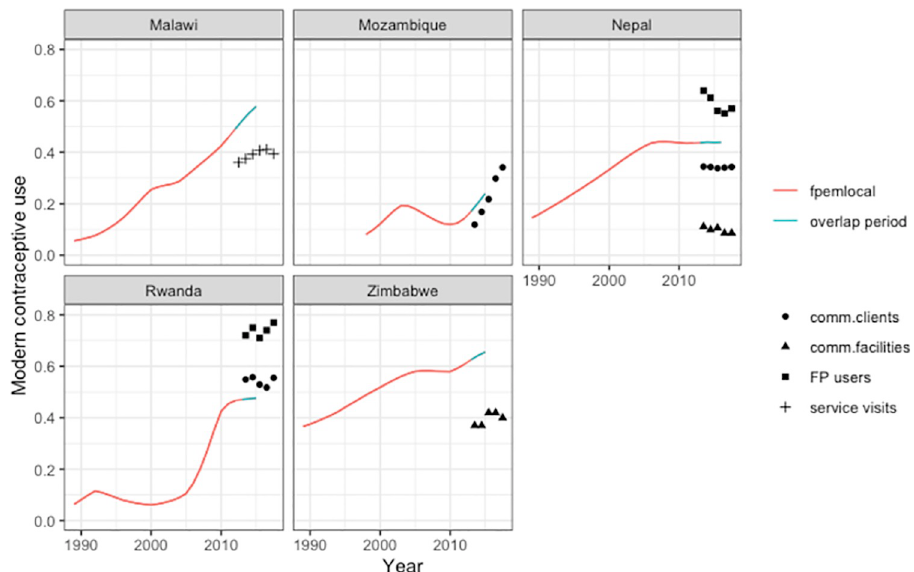
Fig 2. Comparing EMU to model-based mCPR. The symbols represent observations of different EMU data types, depending on availability in the country. The lines are survey informed estimates of mCPR obtained from fpemlocal. The line changes from red to green to indicate the time period where there was an overlap between EMUs and